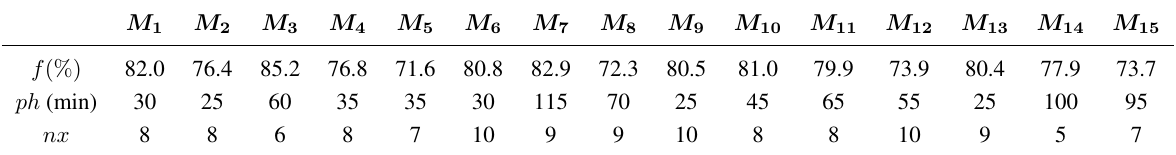
Table 1. Best models’ parameters found for migraines from Patient A with 30 min of future horizon.